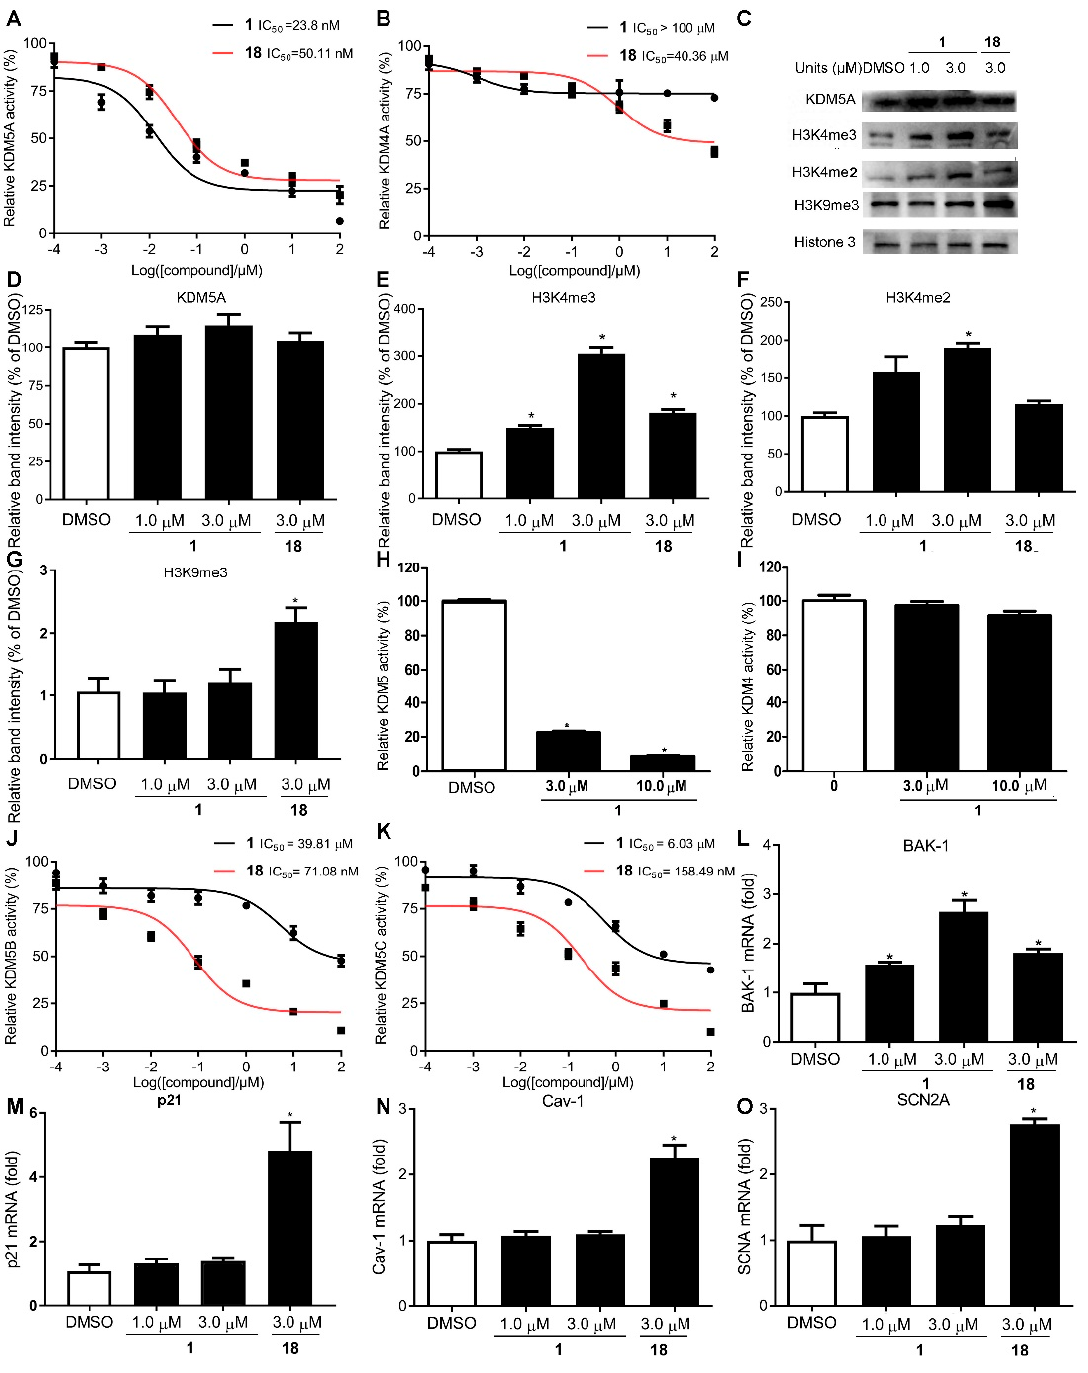
Figure 2. Compound 1 selectively inhibited KDM5A over both KDM4s and other members of KDM5 family. ( A , B ) 1 and 18 dose-dependently inhibits KDM5A ( A ) and KDM4A ( B ) demethylase activity in vitro ; Effects of 1 and 18 on substrate levels of KDM5s and KDM4s i n cellulo are detected by Western blotting ( C , G ), ELISA assay ( H , I ) and RT-qPCR ( L , M ); Effects of 1 and 18 on other members of KDM5 family in vitro and in cellulo are analyzed by chemiluminescence assay ( J , K ) and RT-qPCR ( N , O ). Data are represented as mean ± SD. Student’s t test, * p < 0.05.